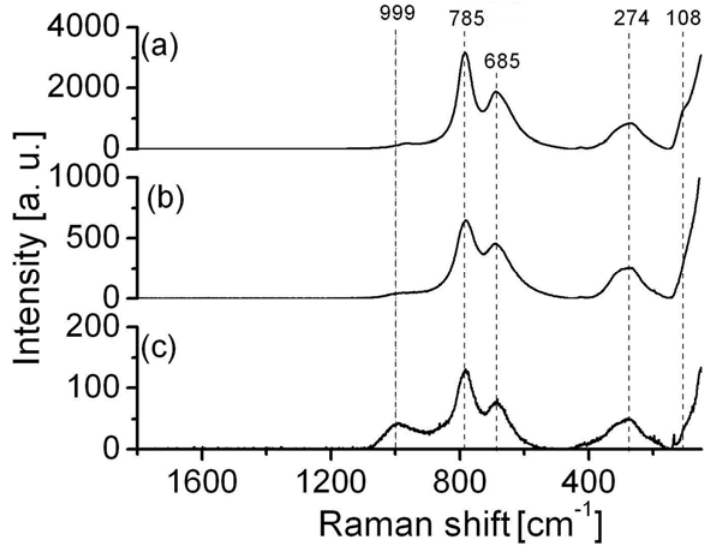
Figure 4. Raman spectra of phosphate tungsten bronzes: (a) reference spectrum; (b) spectrum taken from the middle of green spot; (c) spectrum taken on edge of green spot from Figure 3.